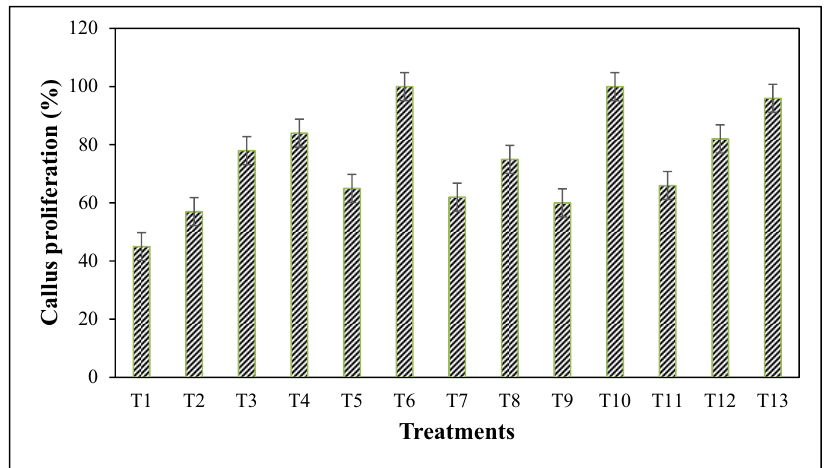
Figure 4: E ff ect of di ff erent treatments on callus proliferation in A. absinthium .